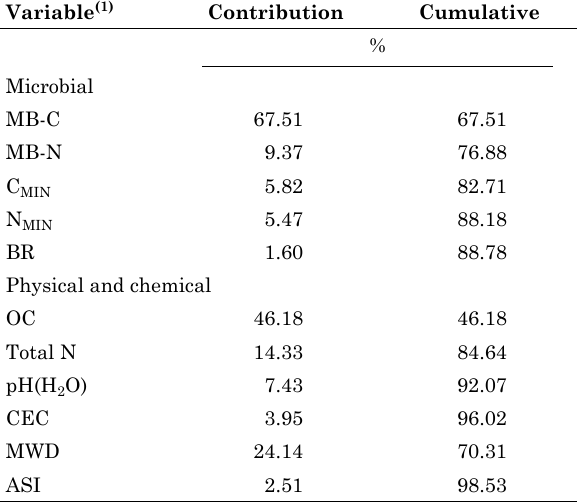
Table 4. Contribution of significant (p≤0.05) soil microbial, physical and chemical variables to data variability according to DistlM analysis